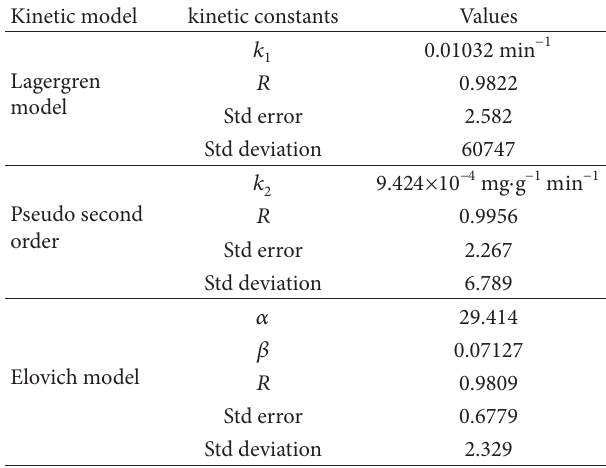
T 4: Comparison of kinetic constants for the adsorption of AO- 7 on ANP. Kinetic